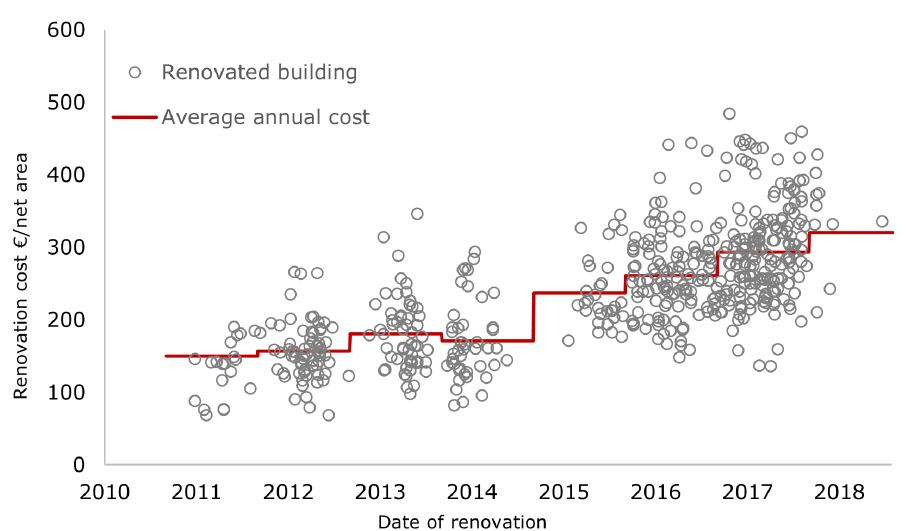
Figure 1. Renovation costs in 2010–2018.